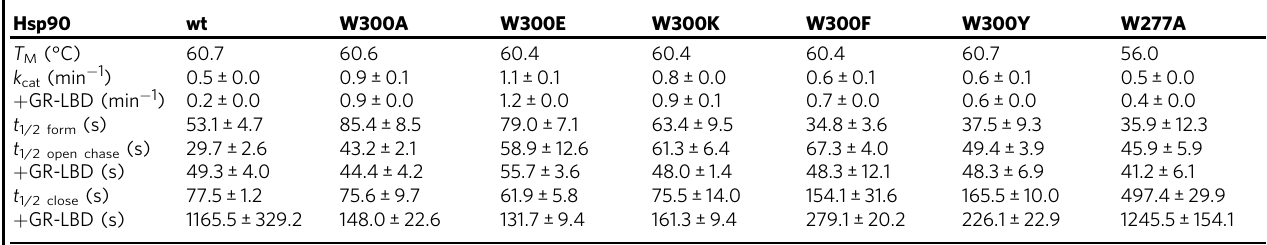
Table 1 Summarized data for the W300/W277 Hsp90 mutants